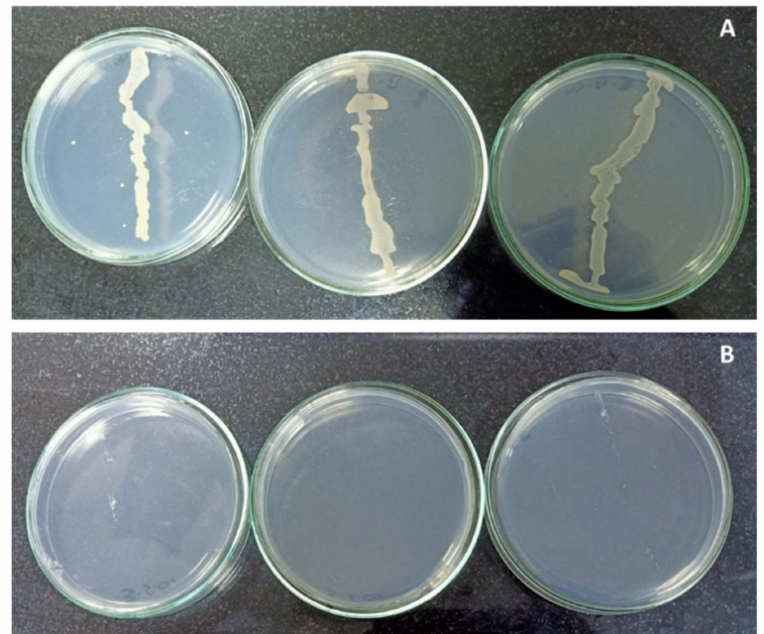
Figure 1. Effect of copper sulphate on endophytic bacteria contamination. Photo ( A ): Control